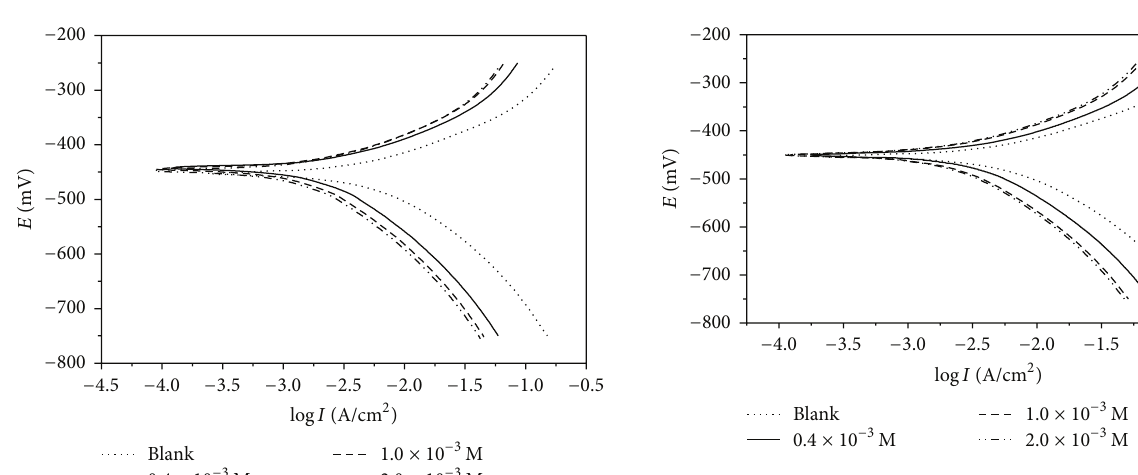
Figure 6: Polarization curves for mild steel in 1 N H 2 SO 4 in the absence and presence of different concentration of inhibitor (02).